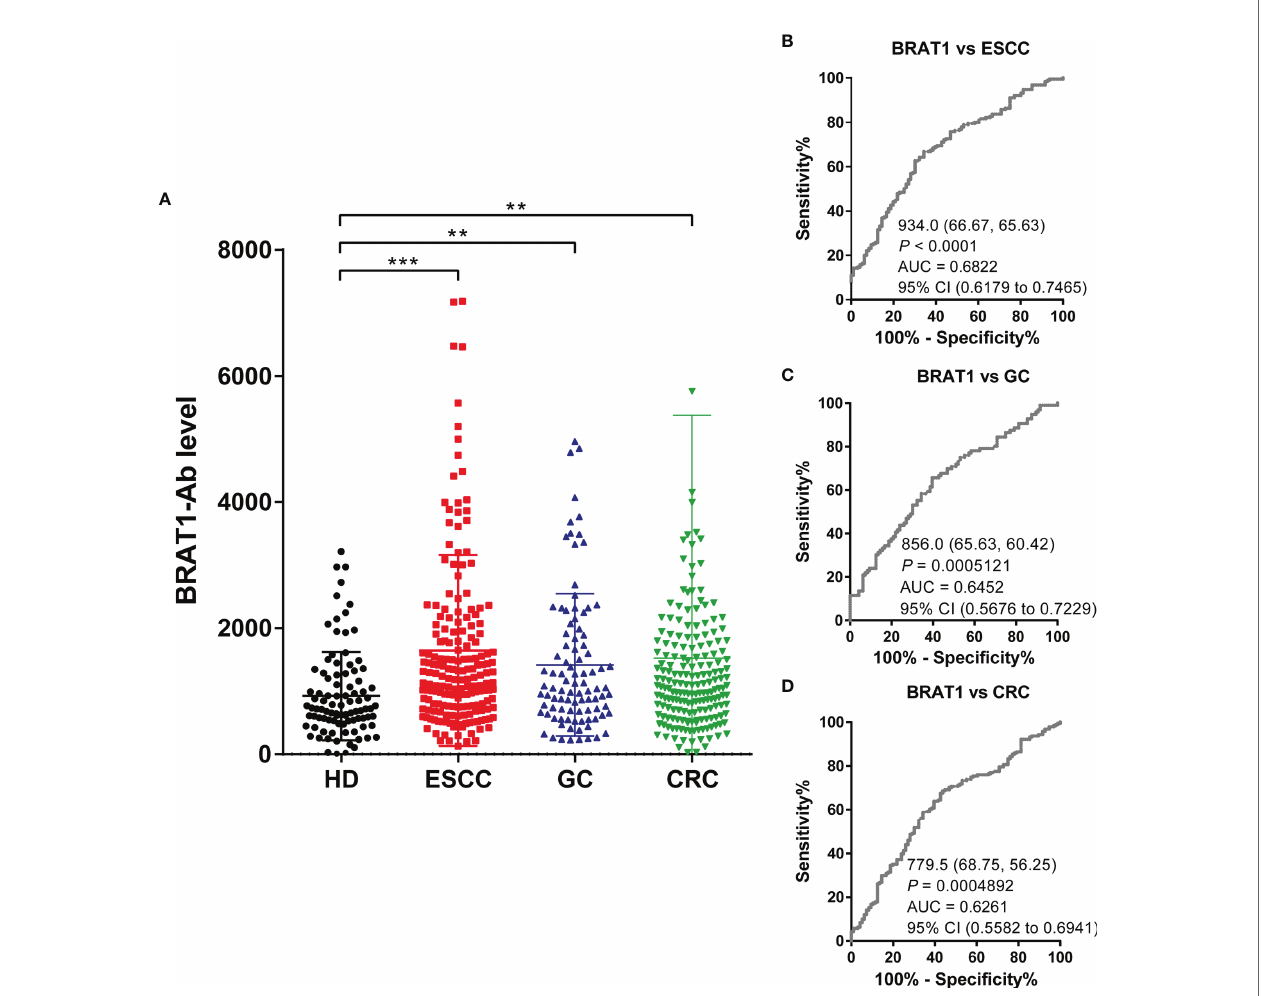
FIGURE 5 | Comparison of serum BRAT1-Abs levels between HDs and patients with gastrointestinal cancers. (A) Serum antibody levels against BRAT1-GST were determined by AlphaLISA. The bars represent the median. The Kruskal – Wallis test was used for calculating P values. The serum number of HDs, ESCC, GC and CRC were 96, 192, 96 and 192, respectively. sensitivity and speci fi city of BRAT1 between ESCC (B) , GC (C) , CRC (D) were evaluated by ROC analysis. Numbers in the fi gure represent cutoff level, speci fi city and sensitivity. ** P < 0.01, *** P <